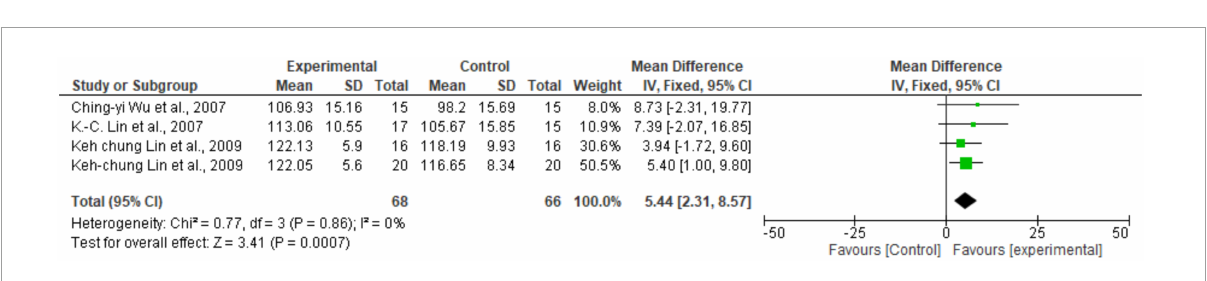
FIGURE7 Forest Plot of the activity/participation assessed by the test Function Independence Measure. SD, standard deviation; CI, confidence